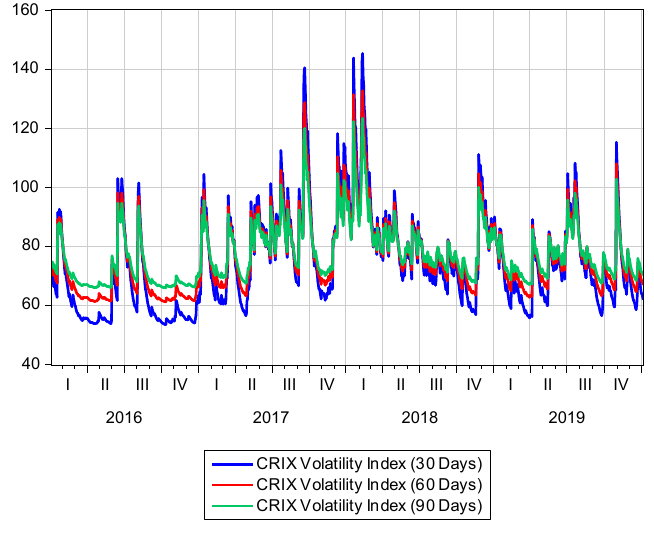
Figure 5. CRIX GARCH(1,1) Volatility